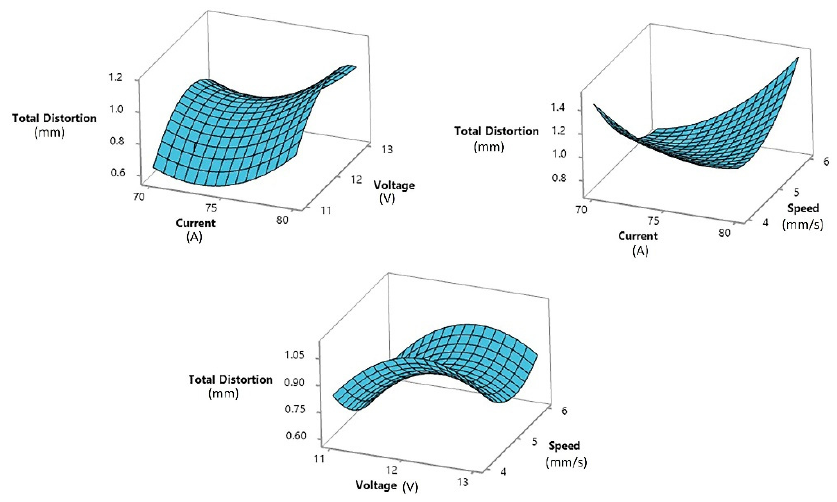
Figure 6. The surface plot of the distortion vs. welding current, voltage, and speed. The surface plot of distortion vs. the welding current and voltage was a saddle-type plot. In this surface plot, the total distortion decreased at the midpoint or 75 A current, but in terms of voltage, the distortion increased at the midpoint voltage of 12 V. In the surface plot of distortion vs. voltage and speed, the same behavior of voltage was observed. The distortion first increased at low voltage; it then increased at the midpoint voltage and again decreased at high voltage. In the same surface plot, the behavior of welding speed could be observed. At low- and high-welding speeds, the distortion value increased, with a minimum distortion value at the midpoint of 5 mm/s. The surface plots of residual stress values for the different weld parameters are shown in Figure 7. Welding speed had a different impact on the residual stress. The resid- ual stress decreased with increasing welding speed. In terms of voltage, a lower value of residual stress was observed at minimum voltage. In terms of current, it was the midpoint value of 75 A that produced the minimum residual stress. Figure 7. The surface plot of the distortion vs. welding current, voltage, and speed . 3.3. Overlaid Contour Plots Contour plots are the 2D graphical representation of the response or interest to influ- encing factors on the x - and y -axis of the plot. In the case of multi-objective optimization studies, two contour plots can be overlaid to find optimum regions for both objective